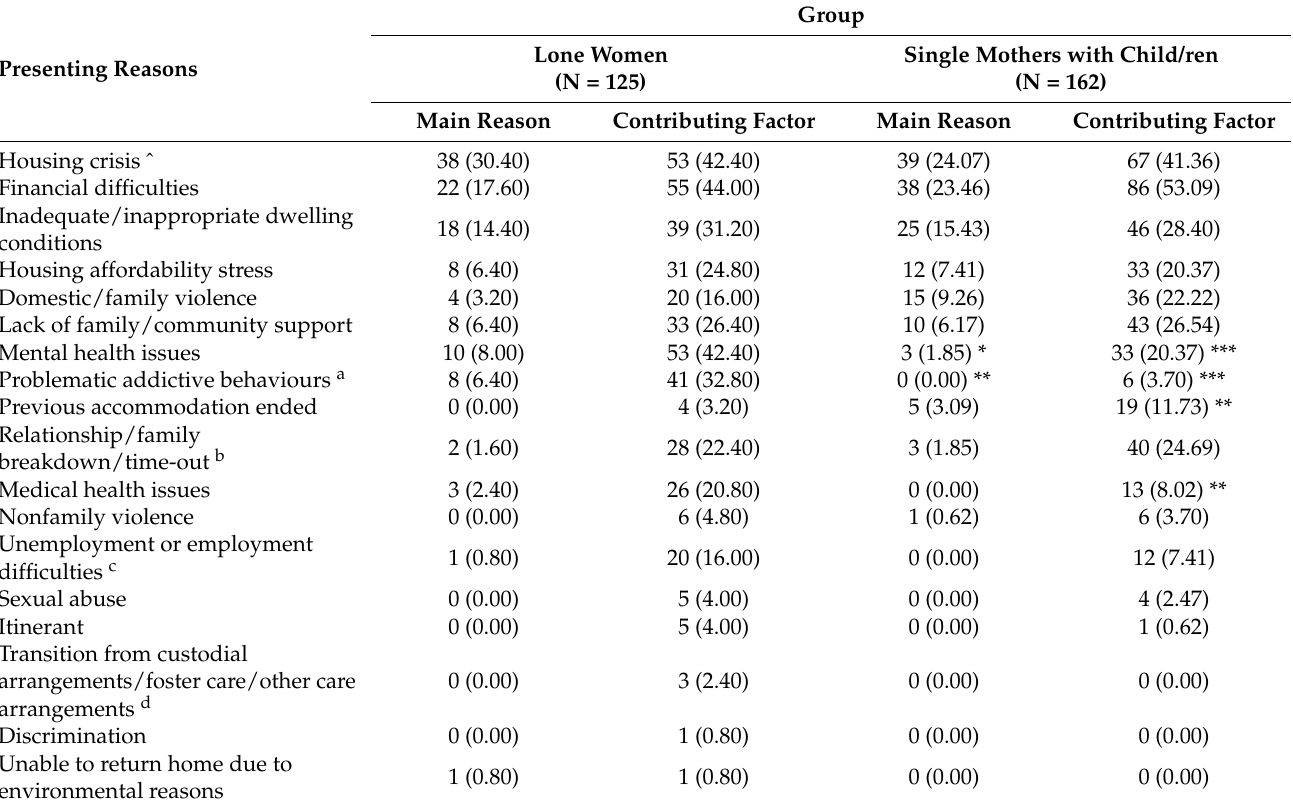
Table 3. Between-group comparisons of main reasons and other contributing factors that led to presentation at support agency according to client group (N =